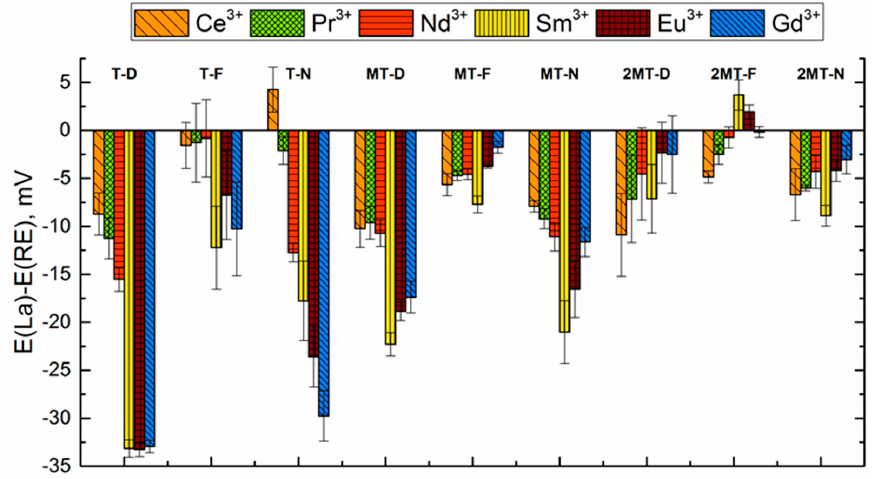
Figure 5. Biionic potentials in solutions of REEs for the sensors based on TODGA and its methylated derivatives.